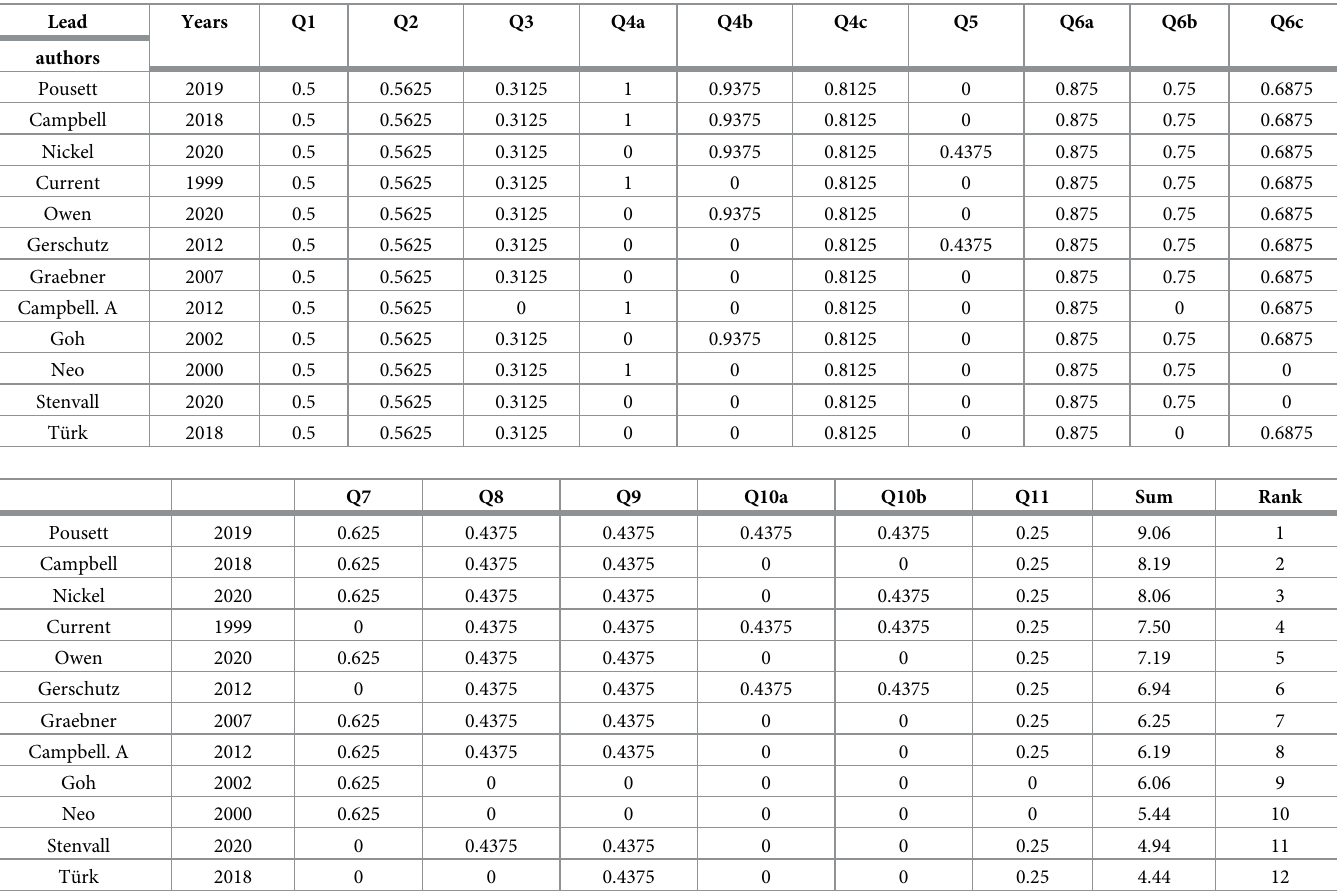
Table 3. Quality assessment within included studies. For description of score items, see S1